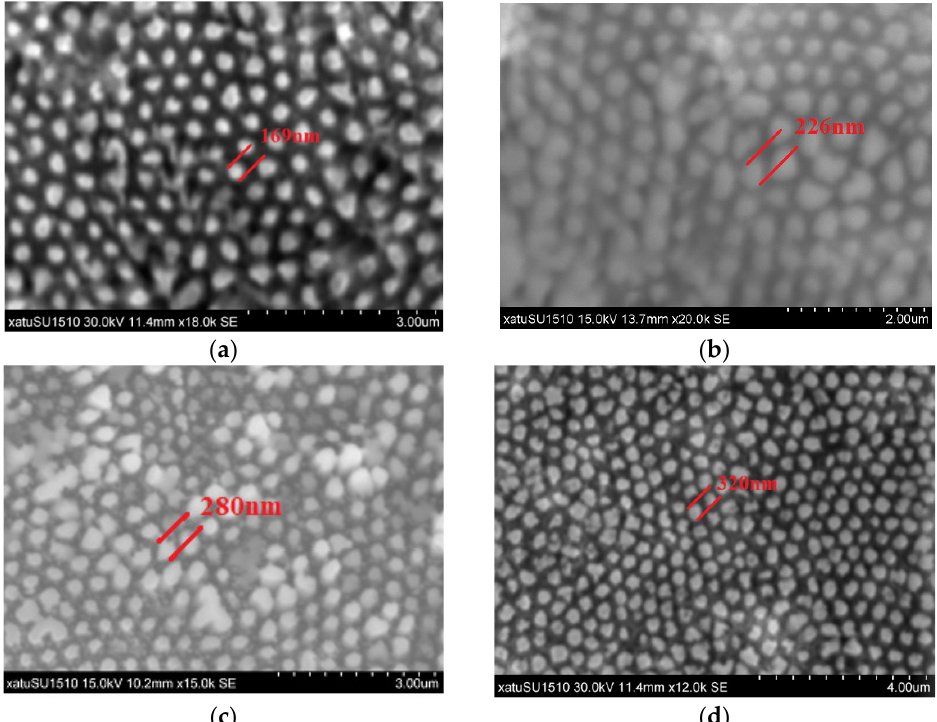
Figure 2. The SEM images of SiNWs fabricated using four different parameters of AAO membranes with the same sputtering parameters: ( a ) DP450-200S-50000; ( b ) DP450-250S-50000; ( c ) DP450-300S-50000; ( d ) DP450-350S-50000.